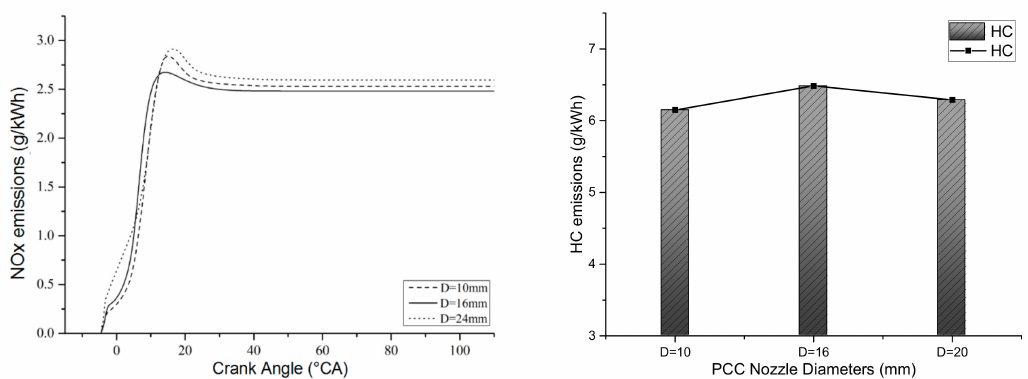
Figure 13. NOx and HC emissions under di ff erent PCC nozzle diameters.